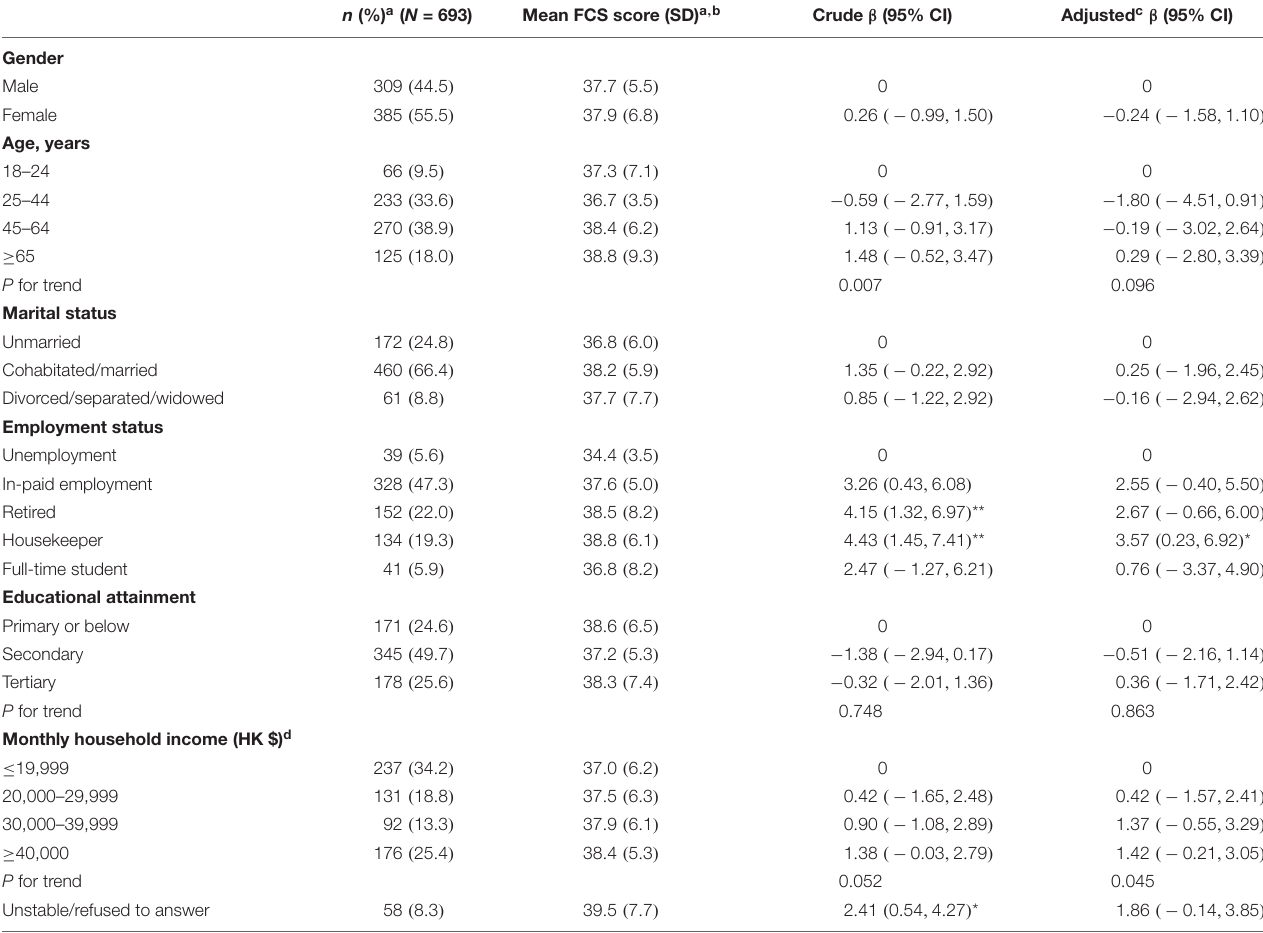
TABLE 5 | Associations of sociodemographic characteristics with Family Communication Scale score in the population-based sample ( N =